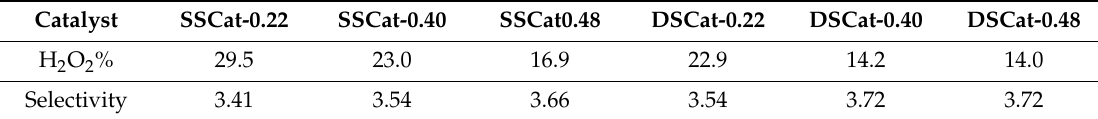
Table 5. Hydrogen peroxide production and selectivities for SSCat and DSCat at R = 0.22, 0.40, 0.48.